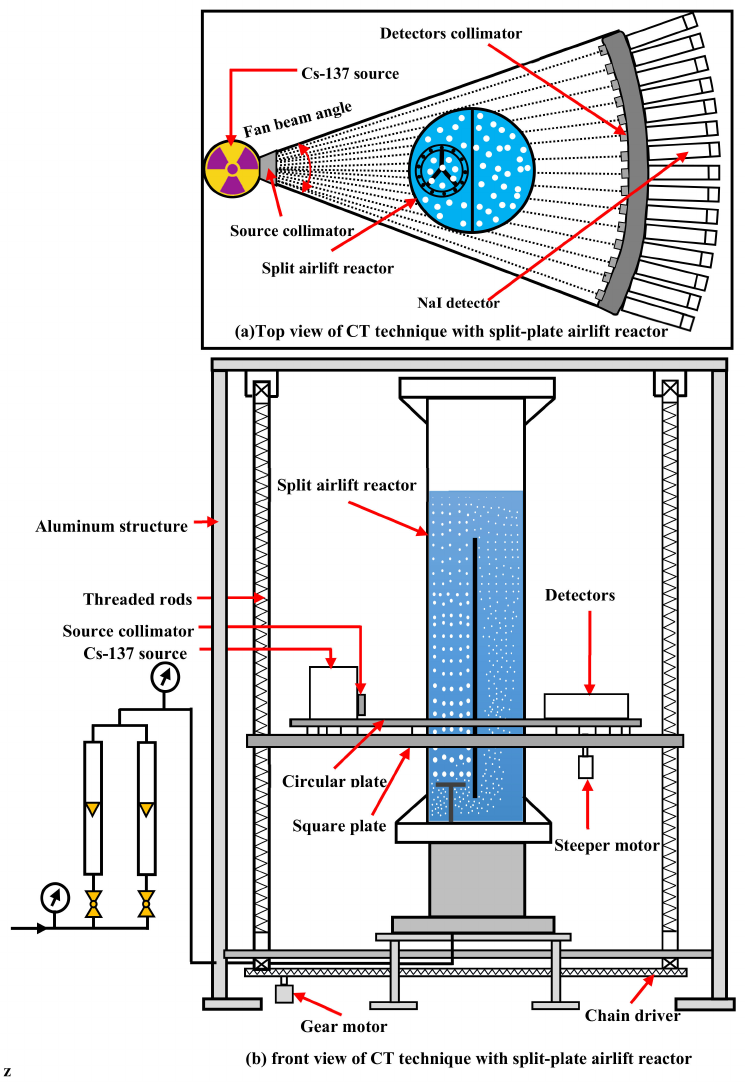
Figure 3. Schematic diagram of the CT technique with the split-plate airlift